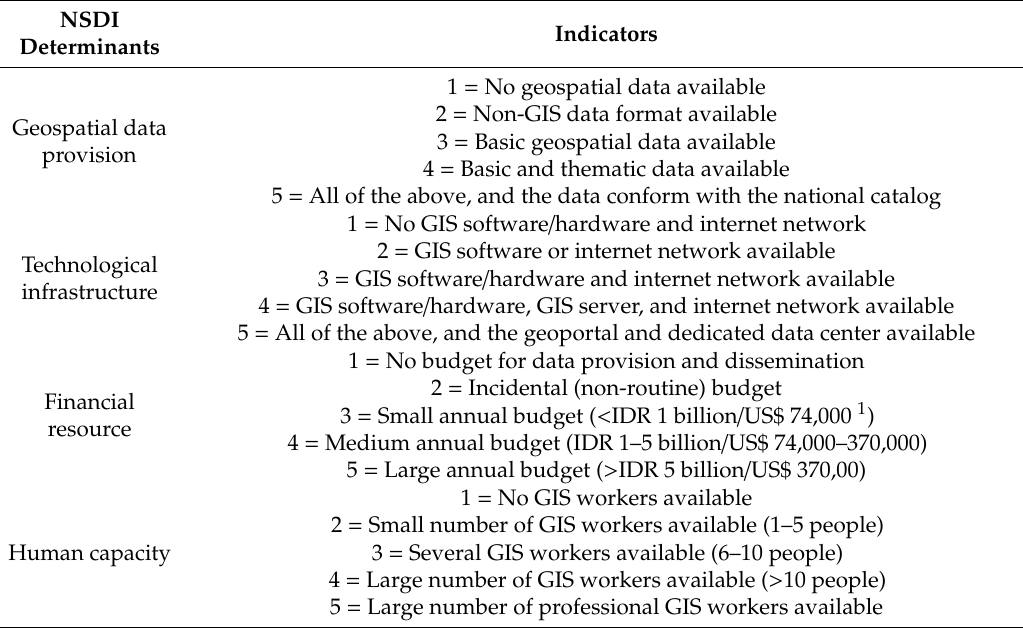
Table A2. National spatial data infrastructure (NSDI) determinants and their indicators used in the questionnaire.